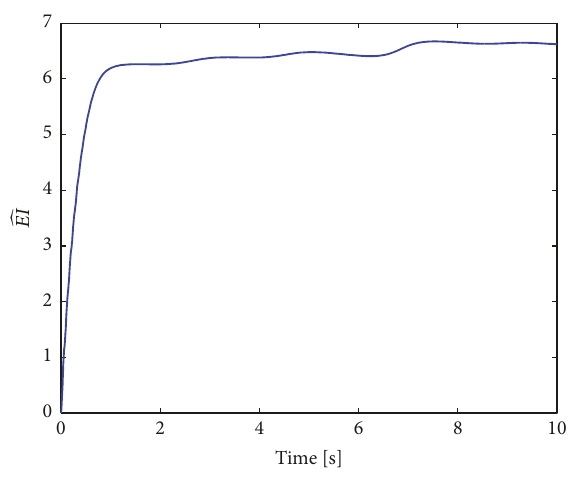
Figure 10: Estimation value of 𝐸𝐼 .